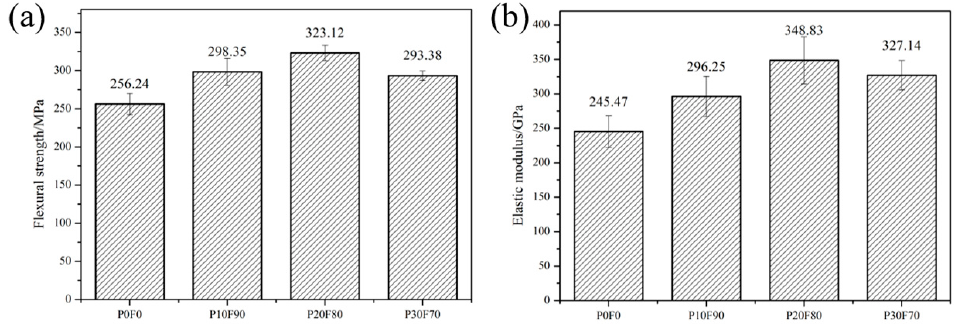
Figure 11. Comparing and demonstrating the performance of P0F0, P10F90, P20F80 and P30F70: ( a ) flexural strength, ( b ) elastic modulus.